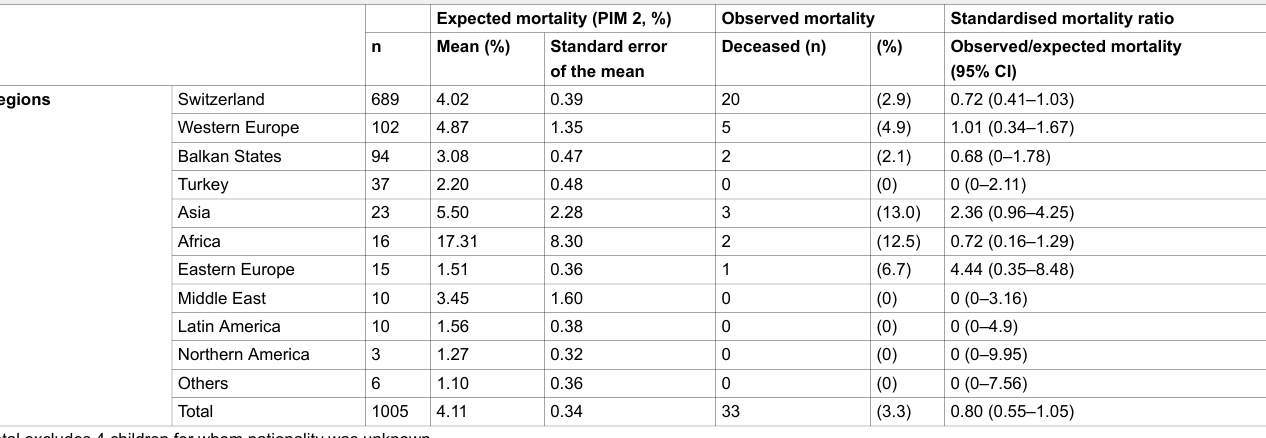
Table 4: Expected mortality (PIM2), observed mortality and standardized mortality ratio by nationality categorised into geographical